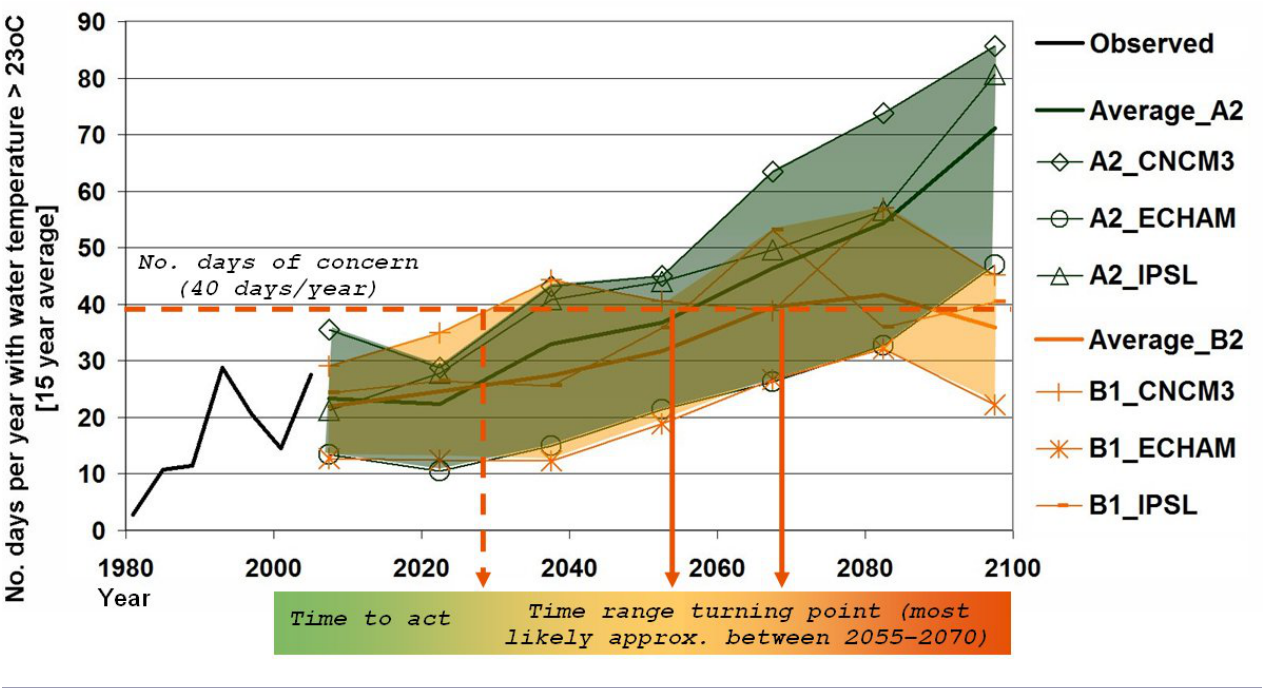
Fig. 2 . Adaptation turning point for the reintroduction of salmon. The figure shows number of days with daily water temperatures exceeding 23°C at Lobith for 1980-2099 (15 year average). Thin lines show individual results for three climate models (CNCM3, ECHAM, and IPSL model), colored polygons show the range in results across the models, and thick line shows the average result from the models for the Special Report on Emissions A2 and B1 climate change scenario (2000-2099; data source: van Vliet et al.